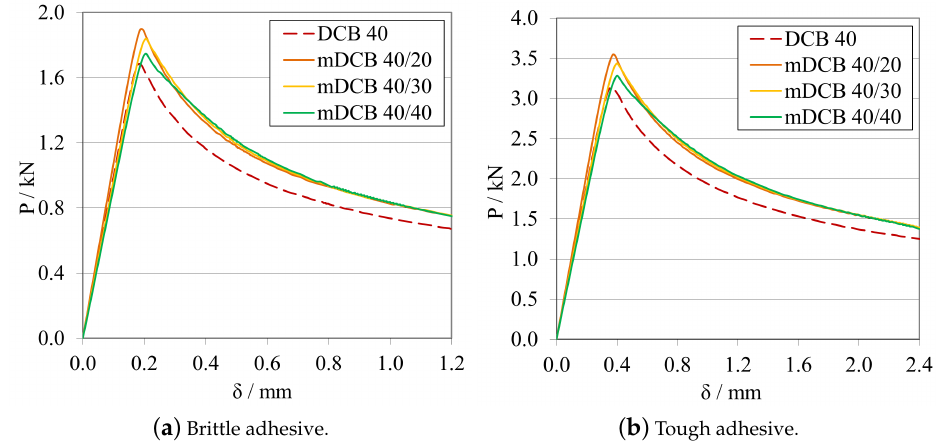
Figure 21. P - δ curves related to a 0 ELS ≤ a 0 mDCB , compared against the correspondent standard